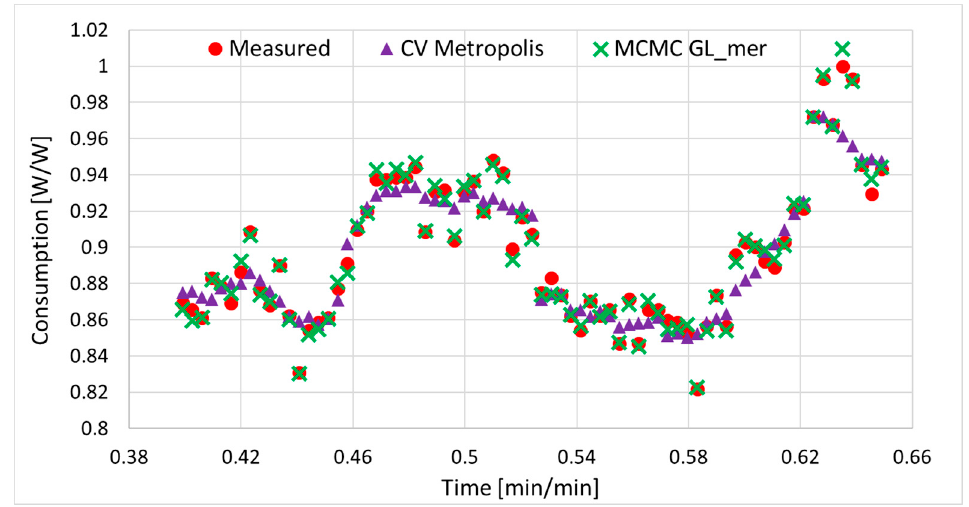
Figure 8. Data (dots) vs. MCMC (triangles) and Cross-Validation (crosses) predictions.